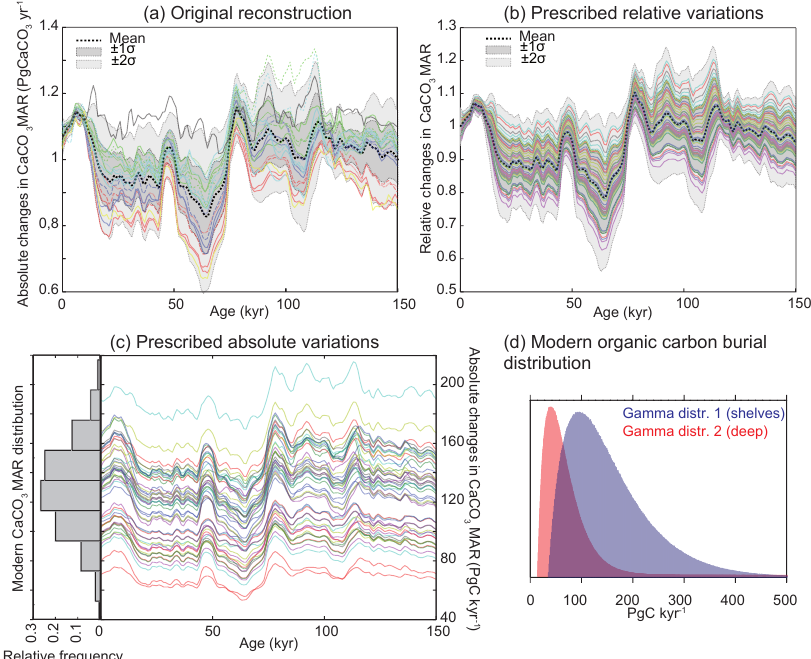
Figure A6. Construction of time series for scenarios. (a) Original reconstruction from the 20 province-map scenarios. (b) Prescribed relative variations derived from the distribution in panel (a) . (c) Prescribed absolute variations derived from the product of (b) and the assigned modern burial distribution (see details in Table 3). (d) Prescribed modern C org burial distribution over shelf (gamma distribution of 1, mean of 160; median of 140; mode of 100; SD of 80) and permanently submerged deep-sea environments (gamma distribution of 2, mean of 70; median of 60; mode of 40; SD of